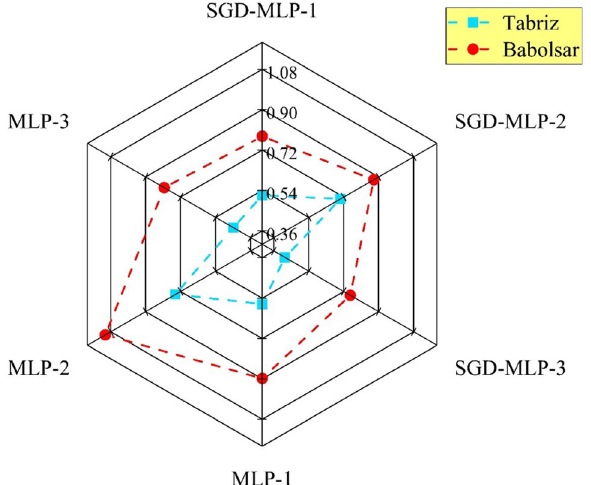
Fig. 5 The best-calculated values of RMSE (mm day-1) for Tabriz and Babolsar stations are shown on this radar